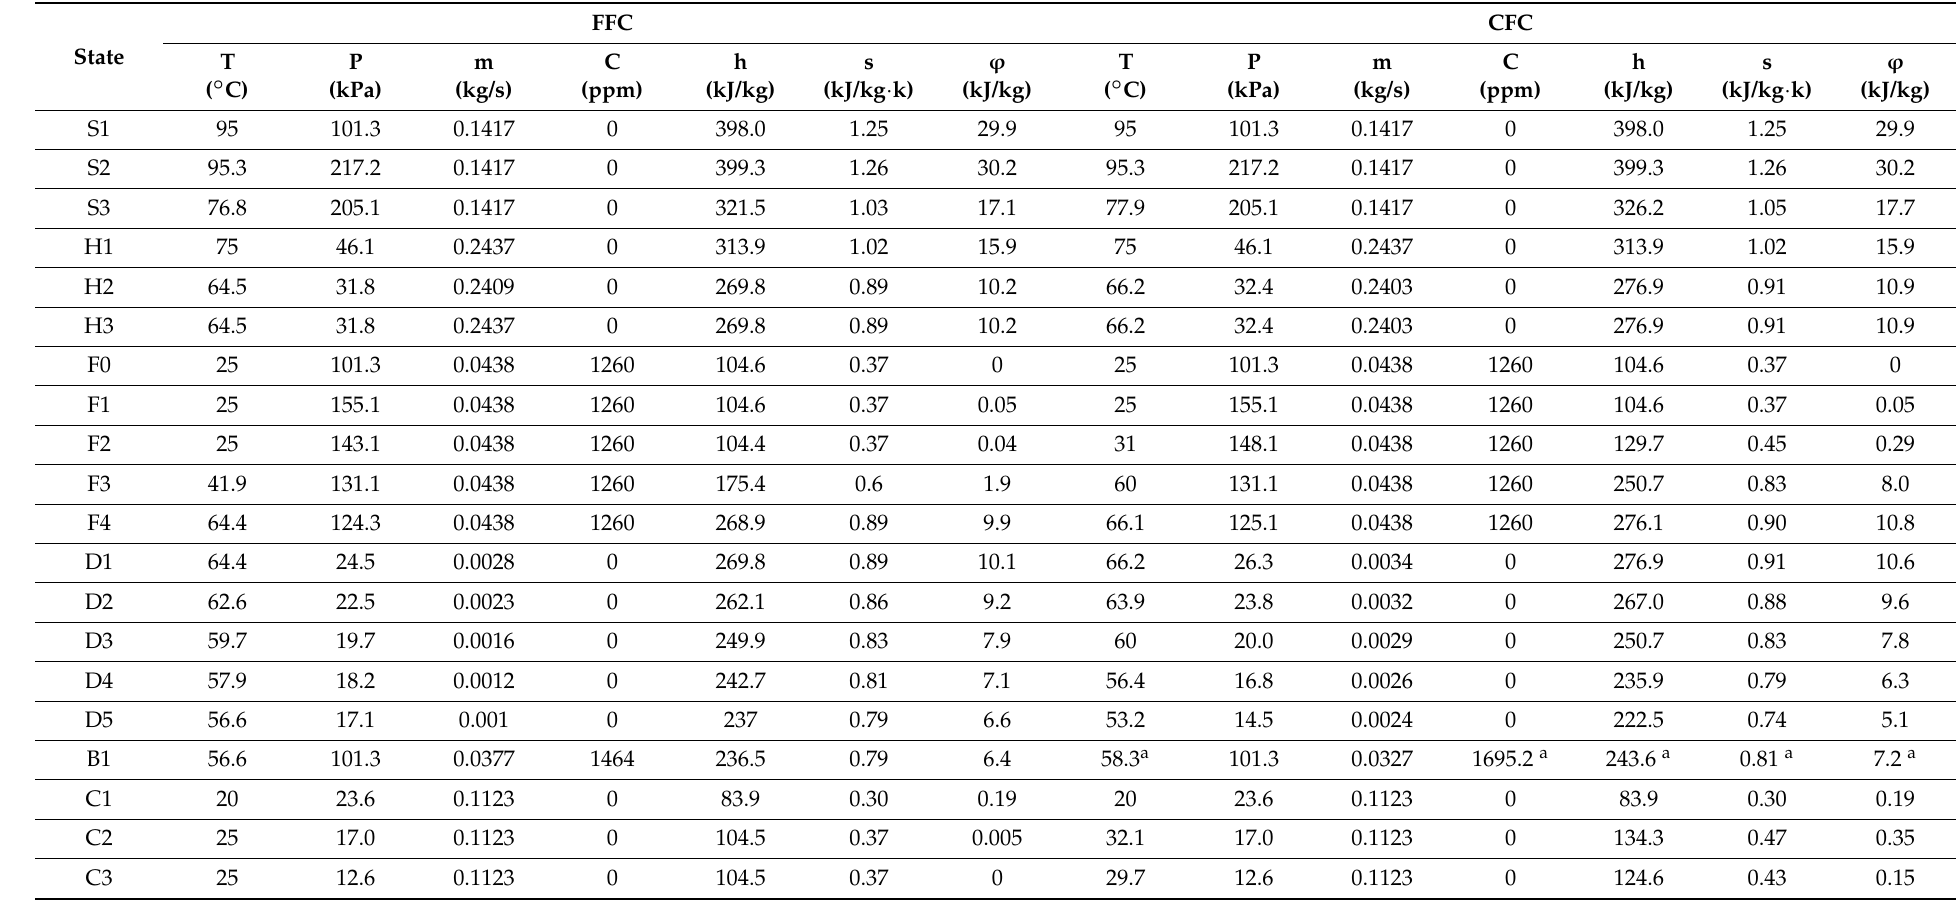
Table 4. Thermodynamics properties of all states in different feed water flow